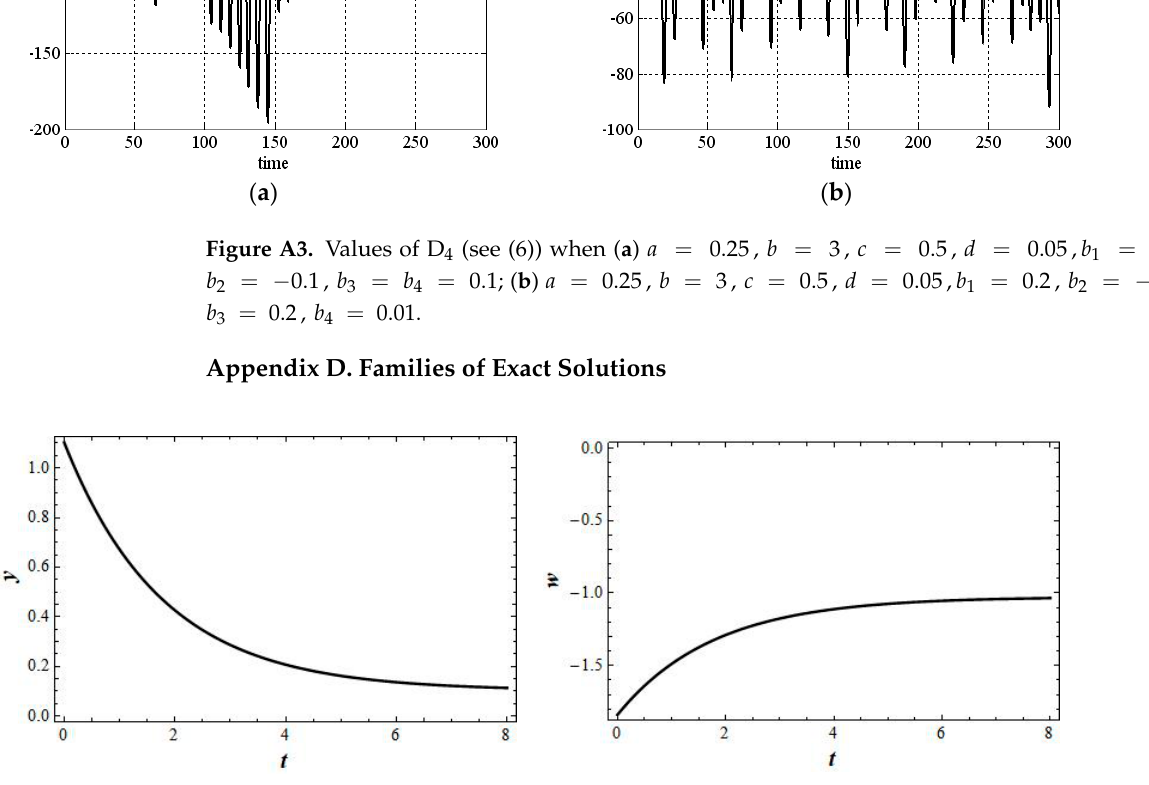
Figure A5. Exact solutions of system (2) when b 1 = − 1.942, b 2 = 1, b 3 = 1.064, b 4 = − 2, k = 1, c 1 = 1, ac ‐ cording to Formula (16). Figure A6. Exact solutions of system (2) when b 1 = 3, b 2 = 1, b 3 = 2, b 4 = − 1, k = − 0.75, c 2 = 1, c 3 = 0, ac ‐ cording to Formulas (18) and (23)–(25). References 1.